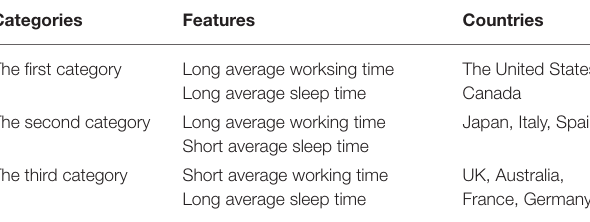
TABLE 10 | Target market classification based on Bayesian